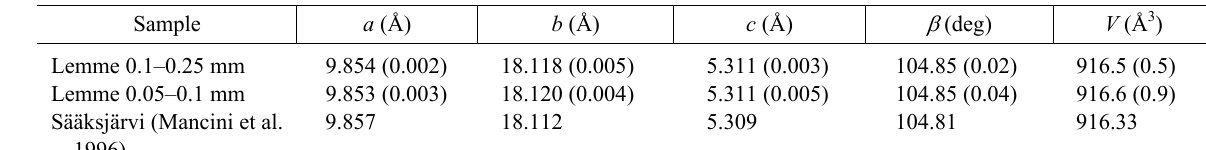
Table 8. Lattice parameters ( a , b , c ), angle ( β ) and unit cell volume ( V ) of amphiboles from Lemme and southwestern Finland (Sääksjärvi). The standard deviations of the Lemme samples are shown in brackets (six samples of 0.05–0.1 mm and nine samples of 0.1–0.25